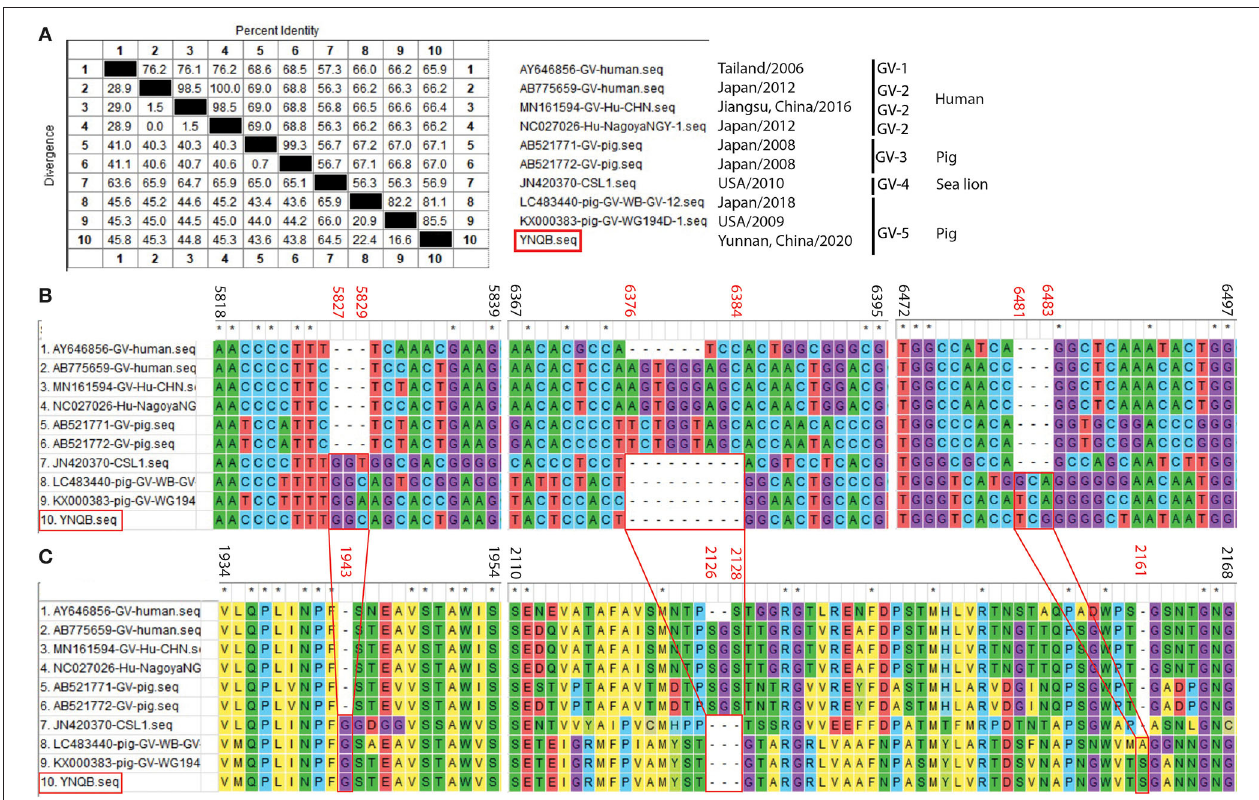
FIGURE 4 | Sequence alignment and analyses of the Yunnan PoSaV-GV strain (YNQB, highlighted in red square) with reference sequences. Similarity of the sequenced genomes of YNQB and nine SaV-GV strains retrieved from NCBI (A) . Nucleotide (B) and amino acid (C) sequence alignment of partial VP1 region of 10 SaV-GV strains. ClustalW method with the default parameters was used to perform the similarity analysis of VP1 sequences of the nine selected SaV-GV reference sequences ( Supplementary Table S3 ) and the Yunnan PoSaV-GV strain obtained in this study. The positions of sequences were provided using KX000383 as reference. On top of the aligned sequences, numbers in black stands for the sequence region in comparison, whereas the numbers in red (5827–5829, 6376–6384, and 6481–6483 in B for nucleic acid locations, whereas 1943, 2126–2128, and 2161 in C for the corresponding amino acid locations) indicate the indel regions, which is highlighted by the red squares and the connecting lines. * indicated identical nucleic acid or amino acid sequences across the porcine sapovirus